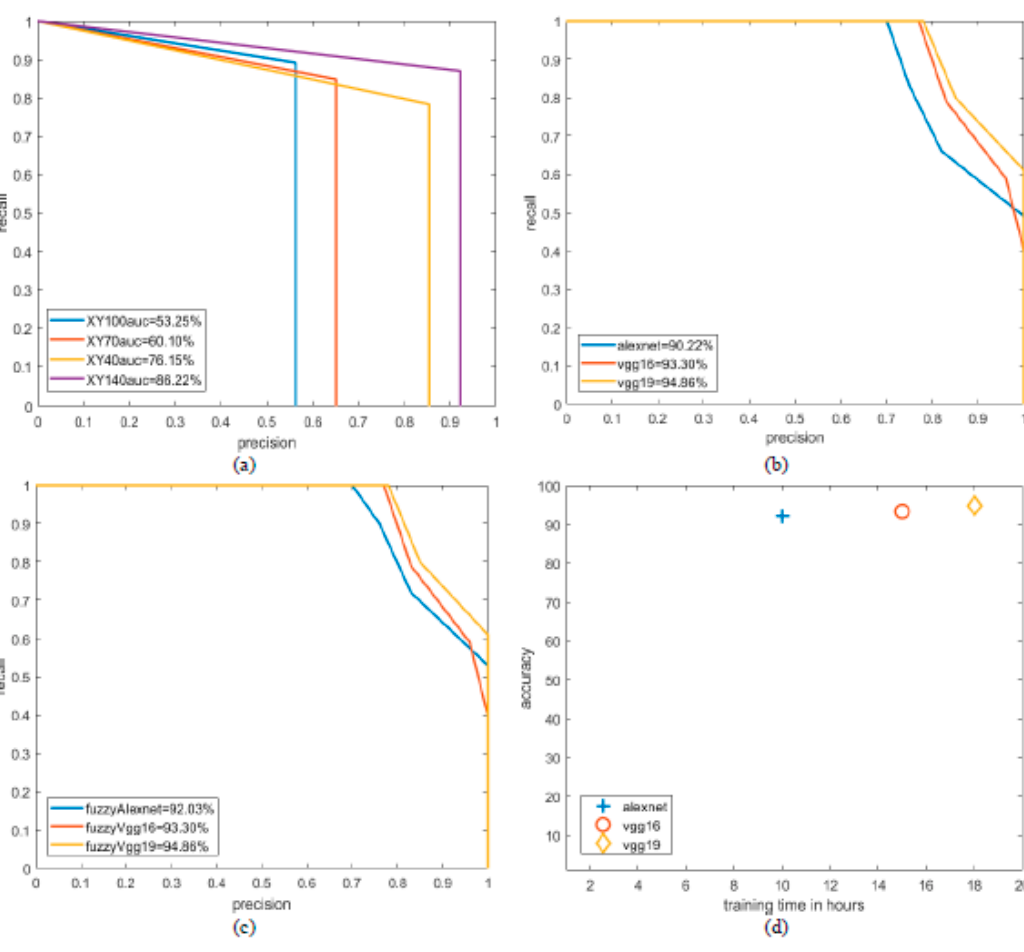
Table 1. Performance